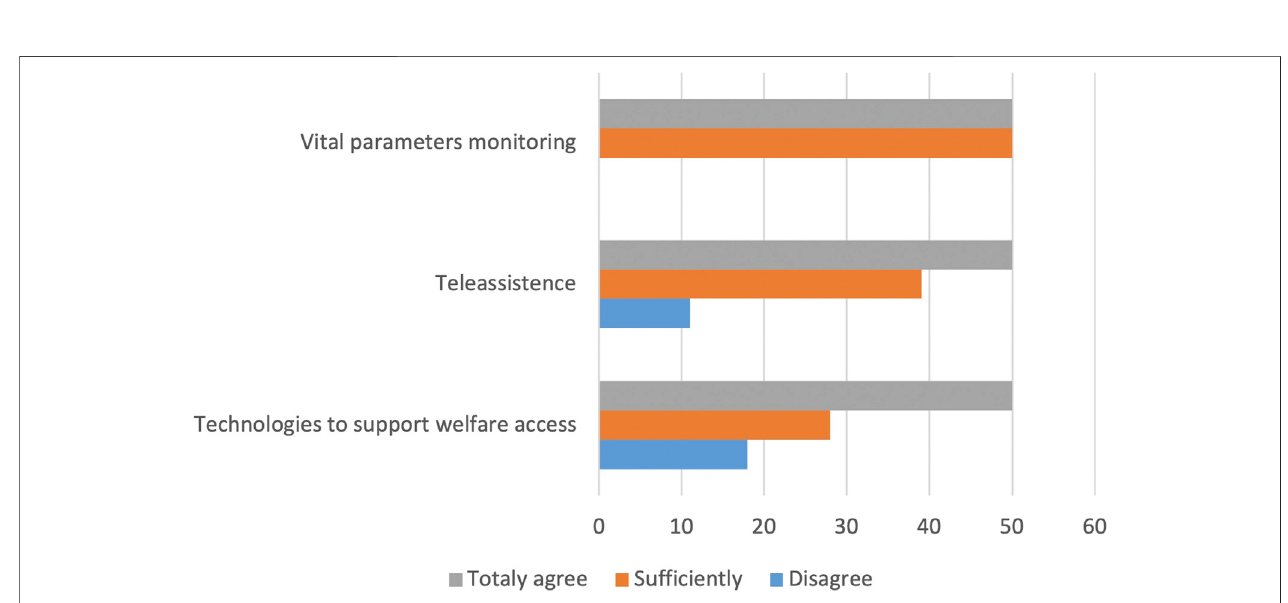
FIGURE 6 | Perception of